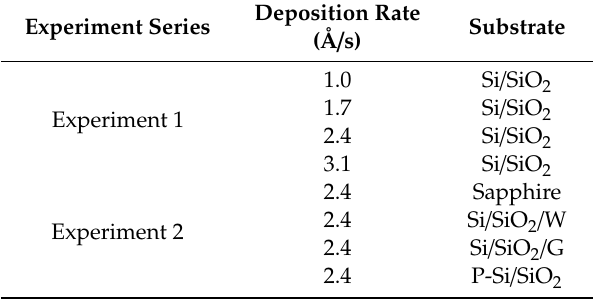
Table 1. Sample treatment regarding deposition rates and substrates. Experiment 1 is an experiment on the morphology of Ag depending on the deposition rate, and Experiment 2 is an experiment on themorphologyofAgdependingonthesubstrate.